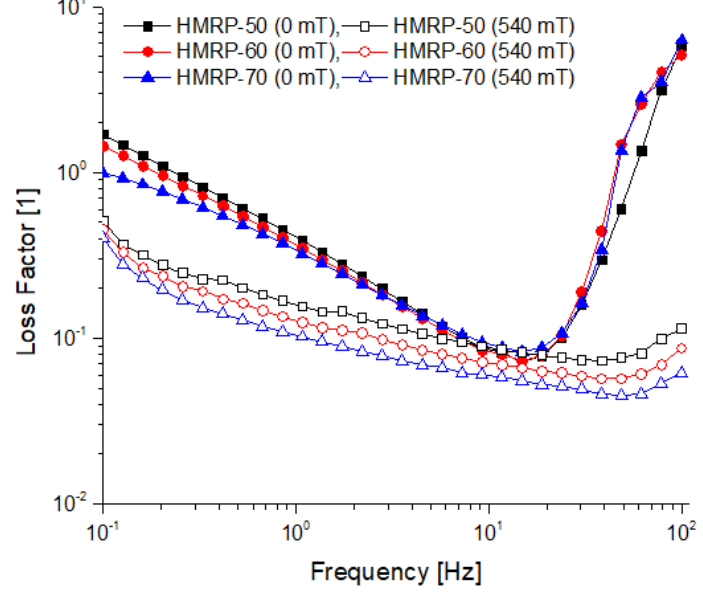
Figure 4. The loss factor of all samples at off-state and on-state conditions